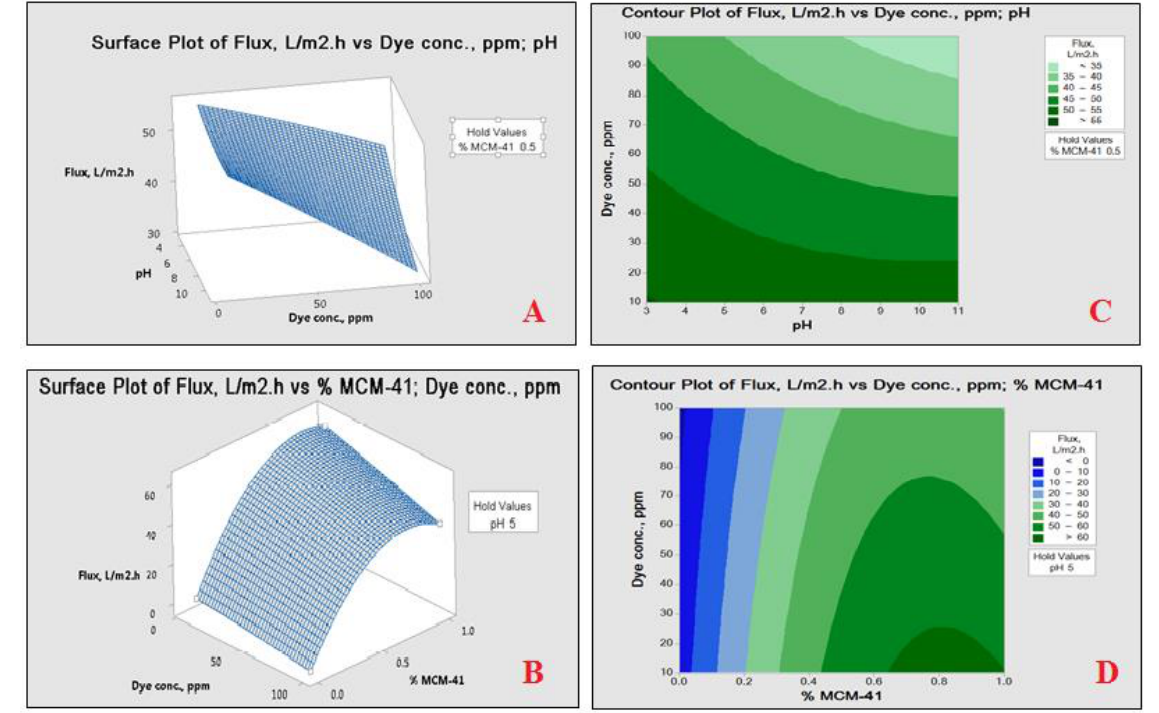
Membranes 2021 , 11 , x FOR PEER REVIEW Figure 6. Three-dimensional response surface plot ( A , B ), and two-dimensional response contour plot ( C , D ) of the permeability as a function of the MCM-41 weight ratio, feed pH, and dye concentration for AB-210 dye.